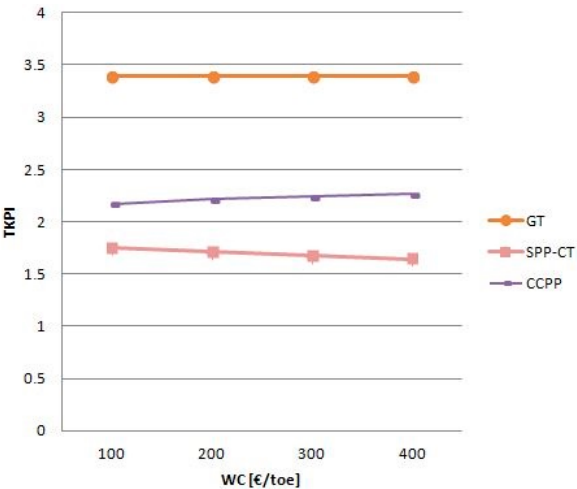
Figure 14. TKPI sensitivity analysis for varying incentive values (alternative design).